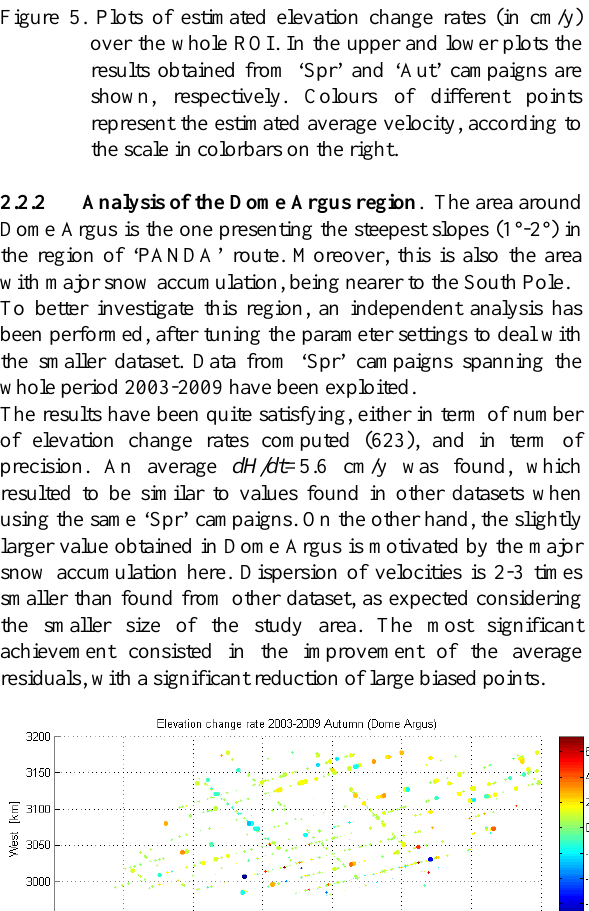
Table 2. Dataset properties, input parameter settings and results of experiments described in Subsect. 2.2. Statistics of results have been averaged over all windows (PAN: ‘PANDA’ route area; ‘D-A’: Dome Argus area; ‘p.w.’: per window).